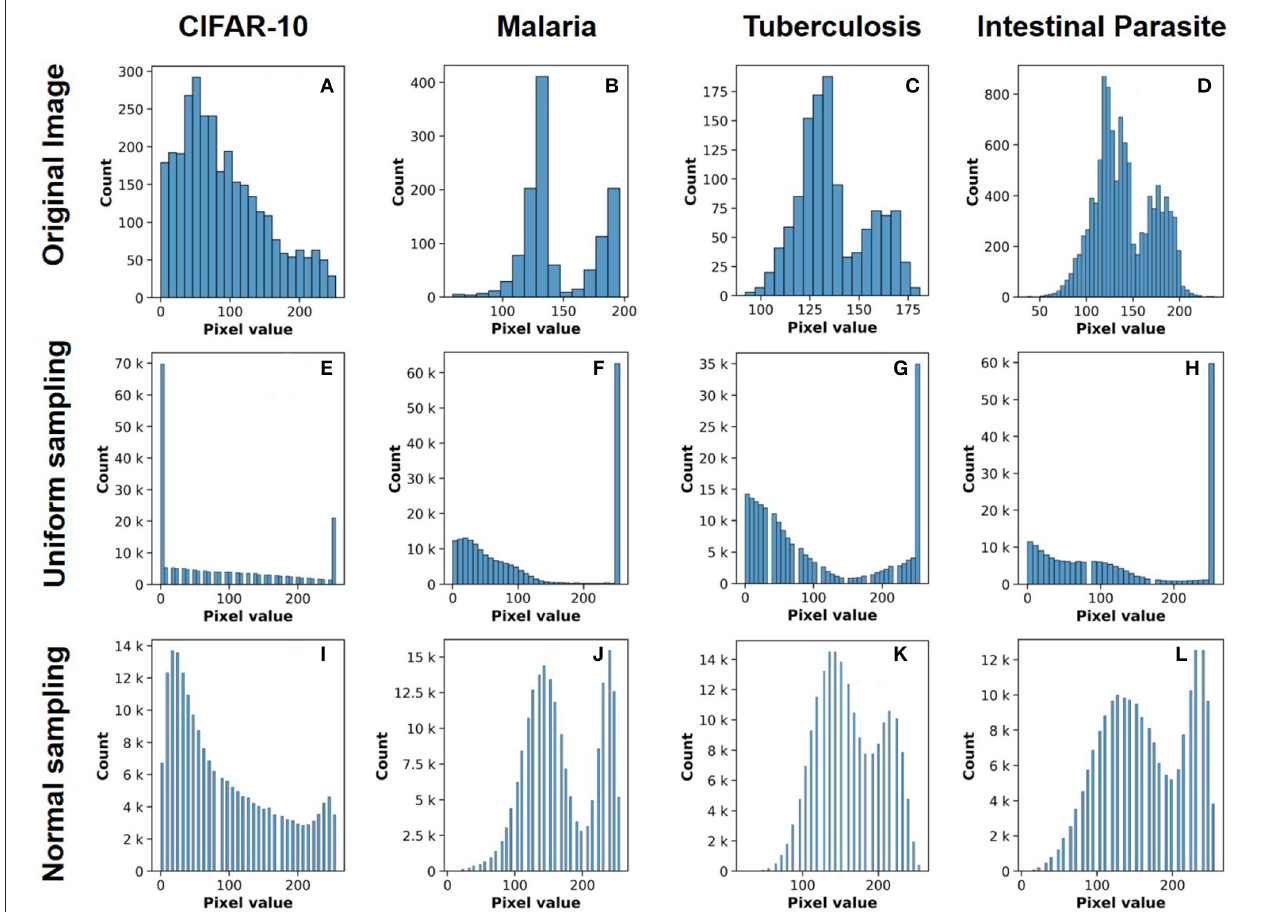
FIGURE 4 | Histograms of pixel-value distribution over image samples from the datasets used in the study: (A–D) original image, (E–H) uniform distribution based stochastic sampling, and (I–L) normal distribution-based stochastic